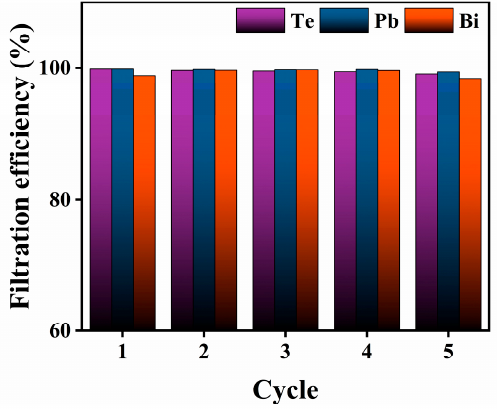
Figure 8. Filtration efficiency in five cycles.